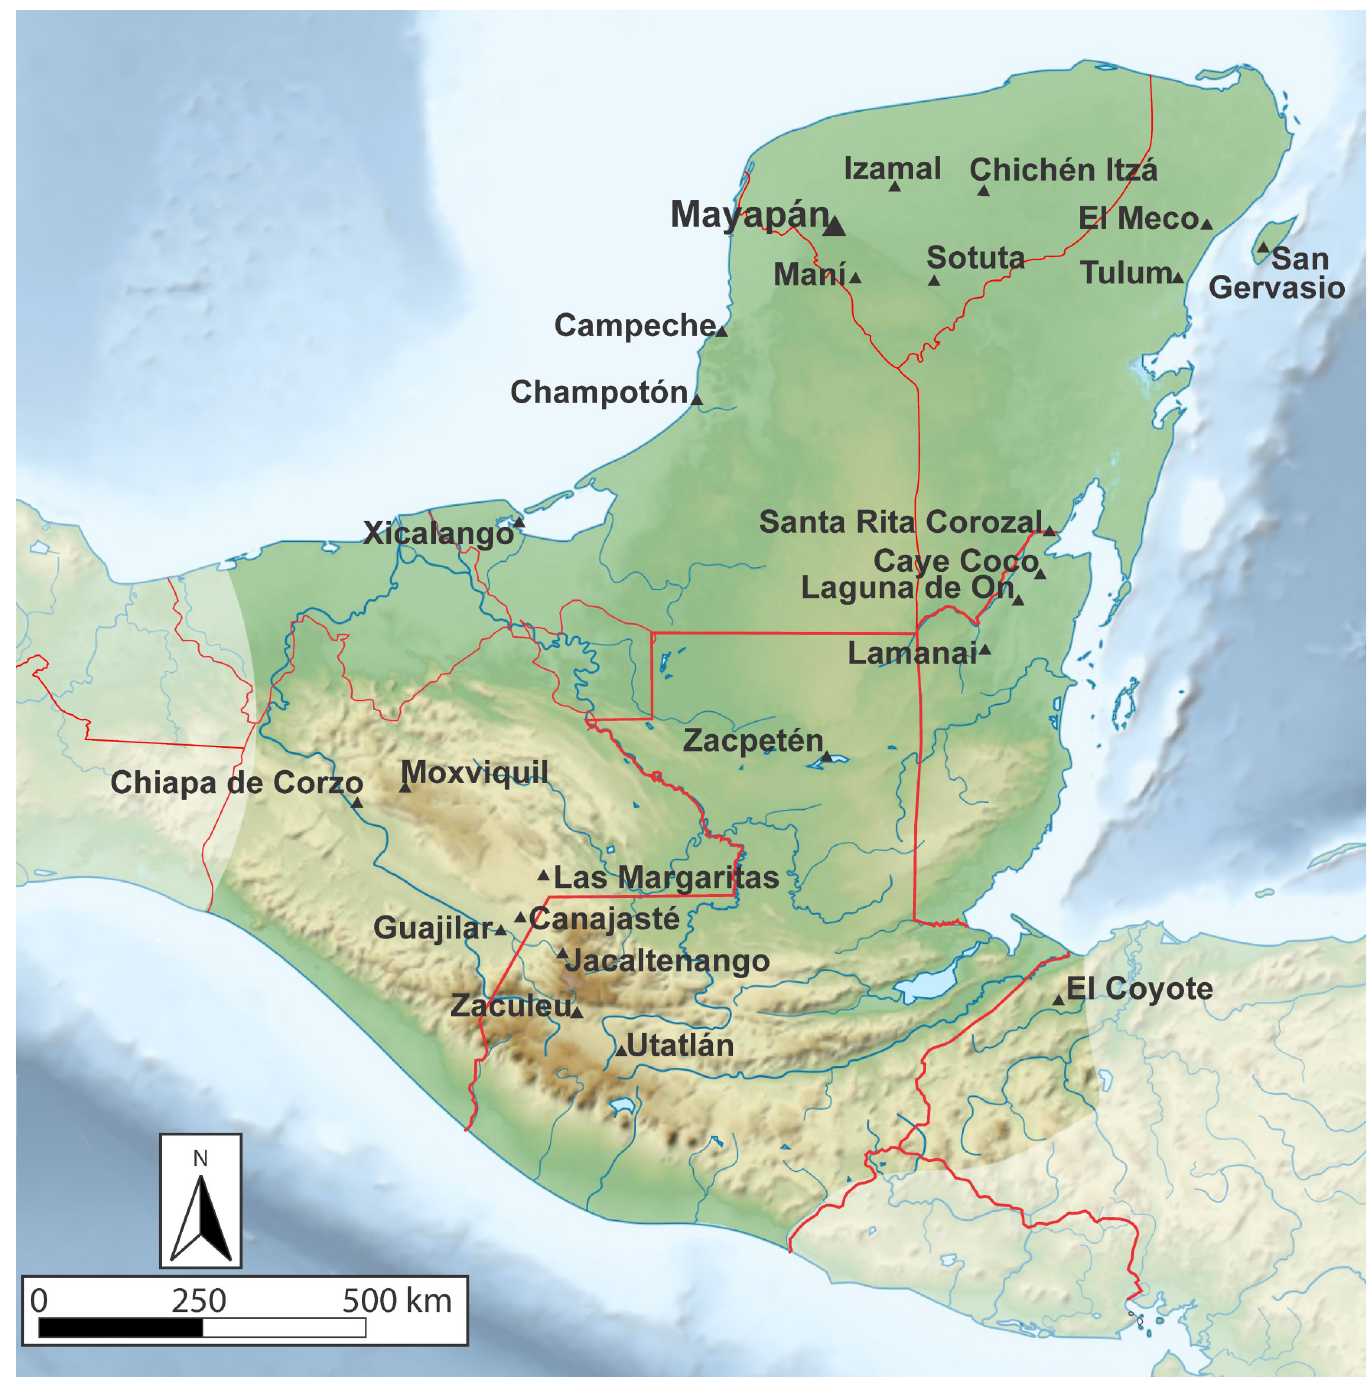
Fig 1. Map of the Maya culture area. Map of the Maya cultural region with sites mentioned in the text. Drafted by Elizabeth Paris, from base map by Wikimedia Commons ( © 2001 Se´mhur/Wikimedia Commons/CC-BY-4.0).